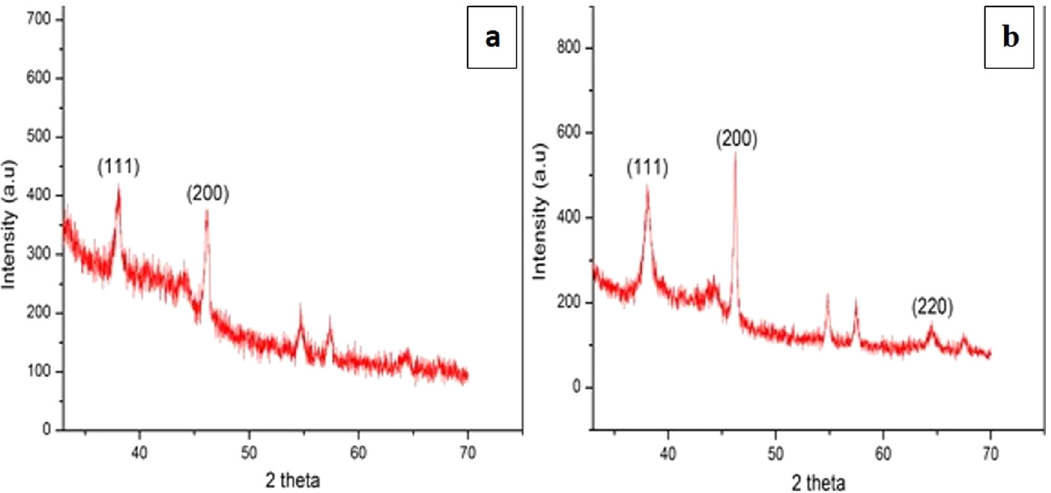
Figure 6: XRD pattern of Ag - NP: ( a ) from leaf and ( b ) from bark of O. ferruginea